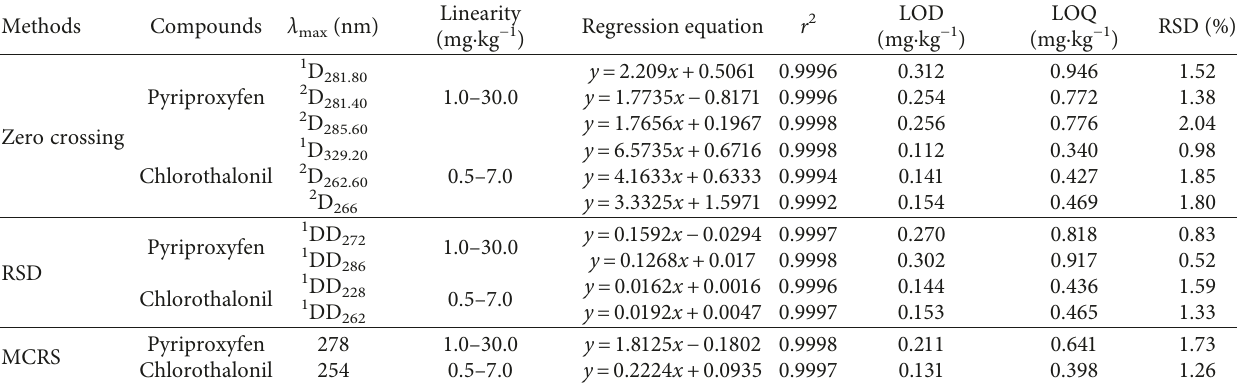
Table 1: The statistical parameter for determination of pyriproxyfen and chlorothalonil by proposed methods. Methods